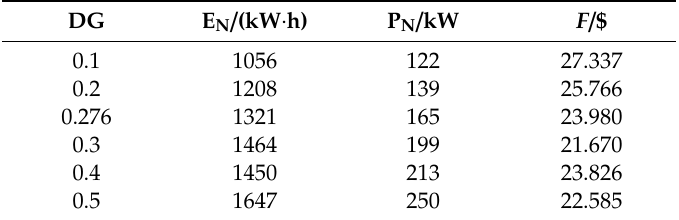
Table 3. Influence of di ff erent permeability of DG on energy storage